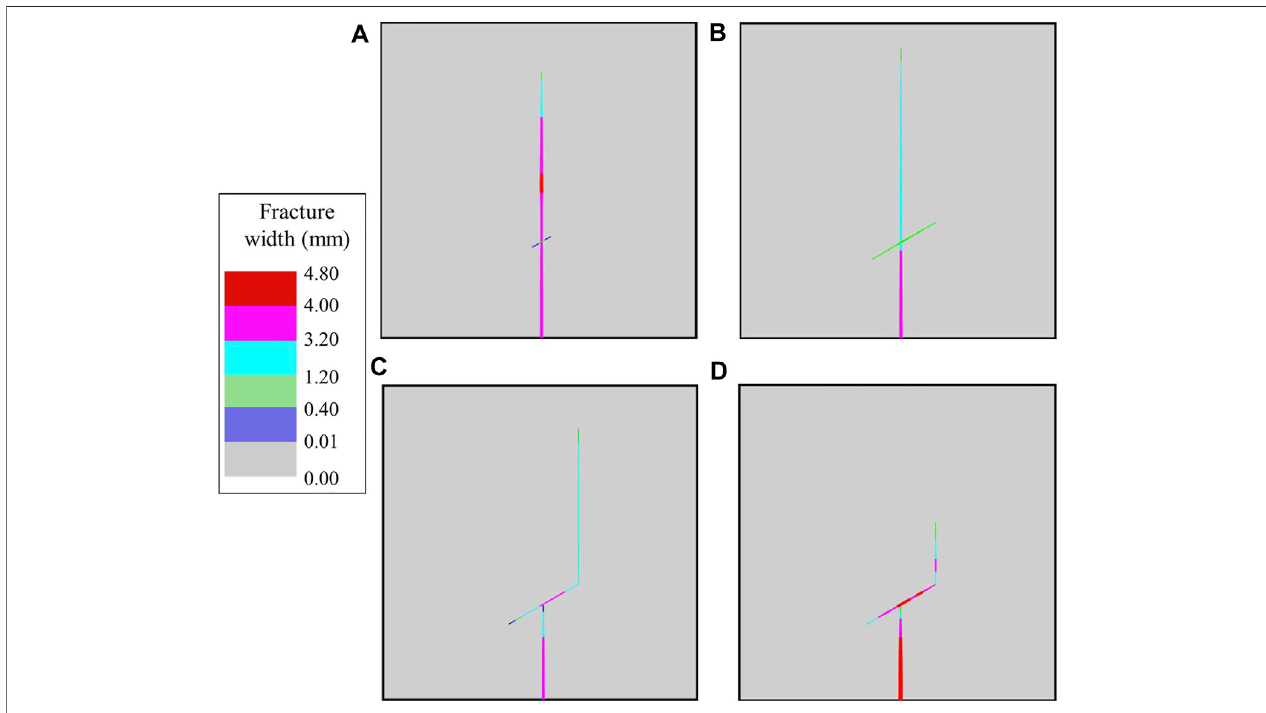
FIGURE 12 | Fracture width and path of the reservoir with a NF with dip angle of 30 ° : (A) 350 mPas, (B) 350 → 3 mPa · s, (C) 3 mPa · s, and (D) 3 → 350 mPa · s.